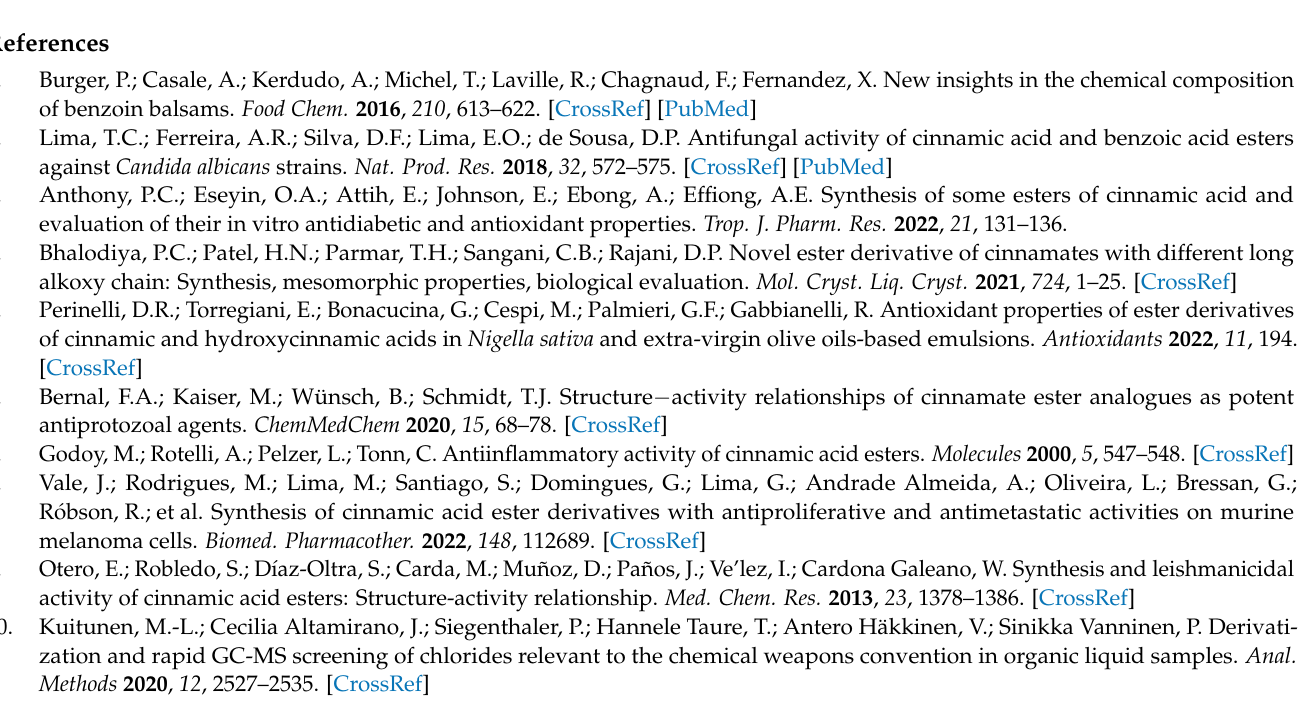
Figure S1: IR spectrum of the title compound 1 ; Figure S2: 1 H NMR spectrum of the title com- pound 1 ; Figure S3: 13 C NMR spectrum of the title compound 1 ; Figure S4: Mass spectrum of the title compound 1